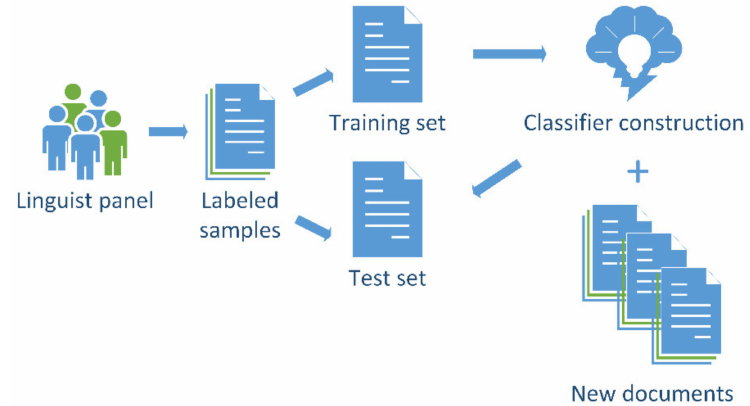
Figure 5. General overview of the classification training using two subsets of labeled samples for generating the